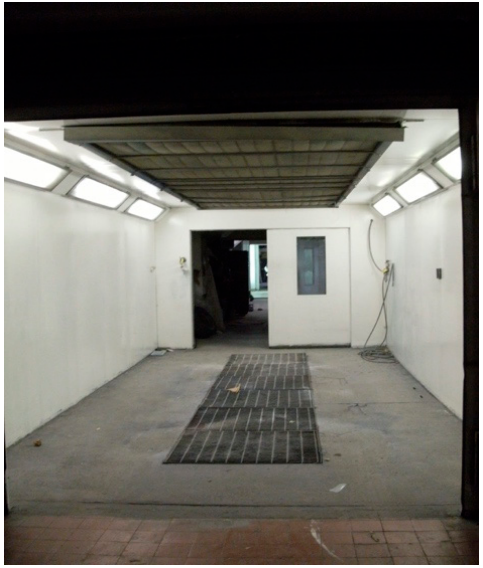
Figure 4. The spray booth at S-O-T Body Repairs (left).